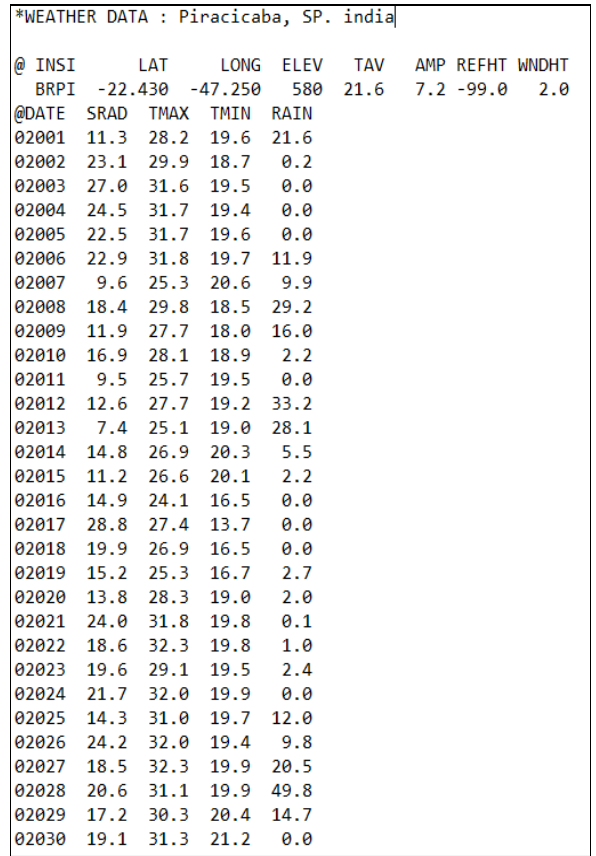
Figure 7. Cultivar data in DSSAT